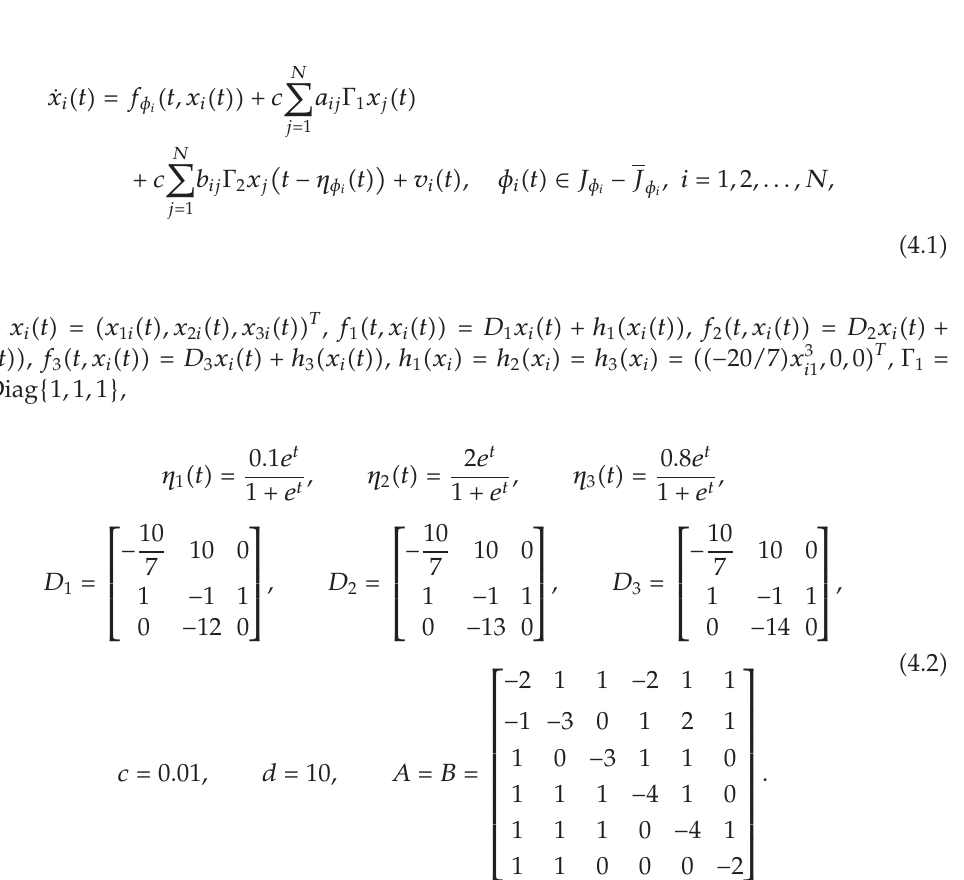
Figure 6: Time evolution of the synchronization error E 23 (cid:6) t (cid:7)